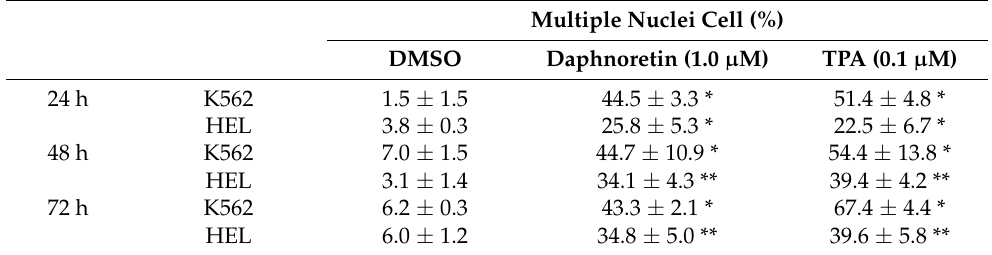
Table 2. Proportion of multiple nuclei cells in daphnoretin and TPA-treated K562 and HEL